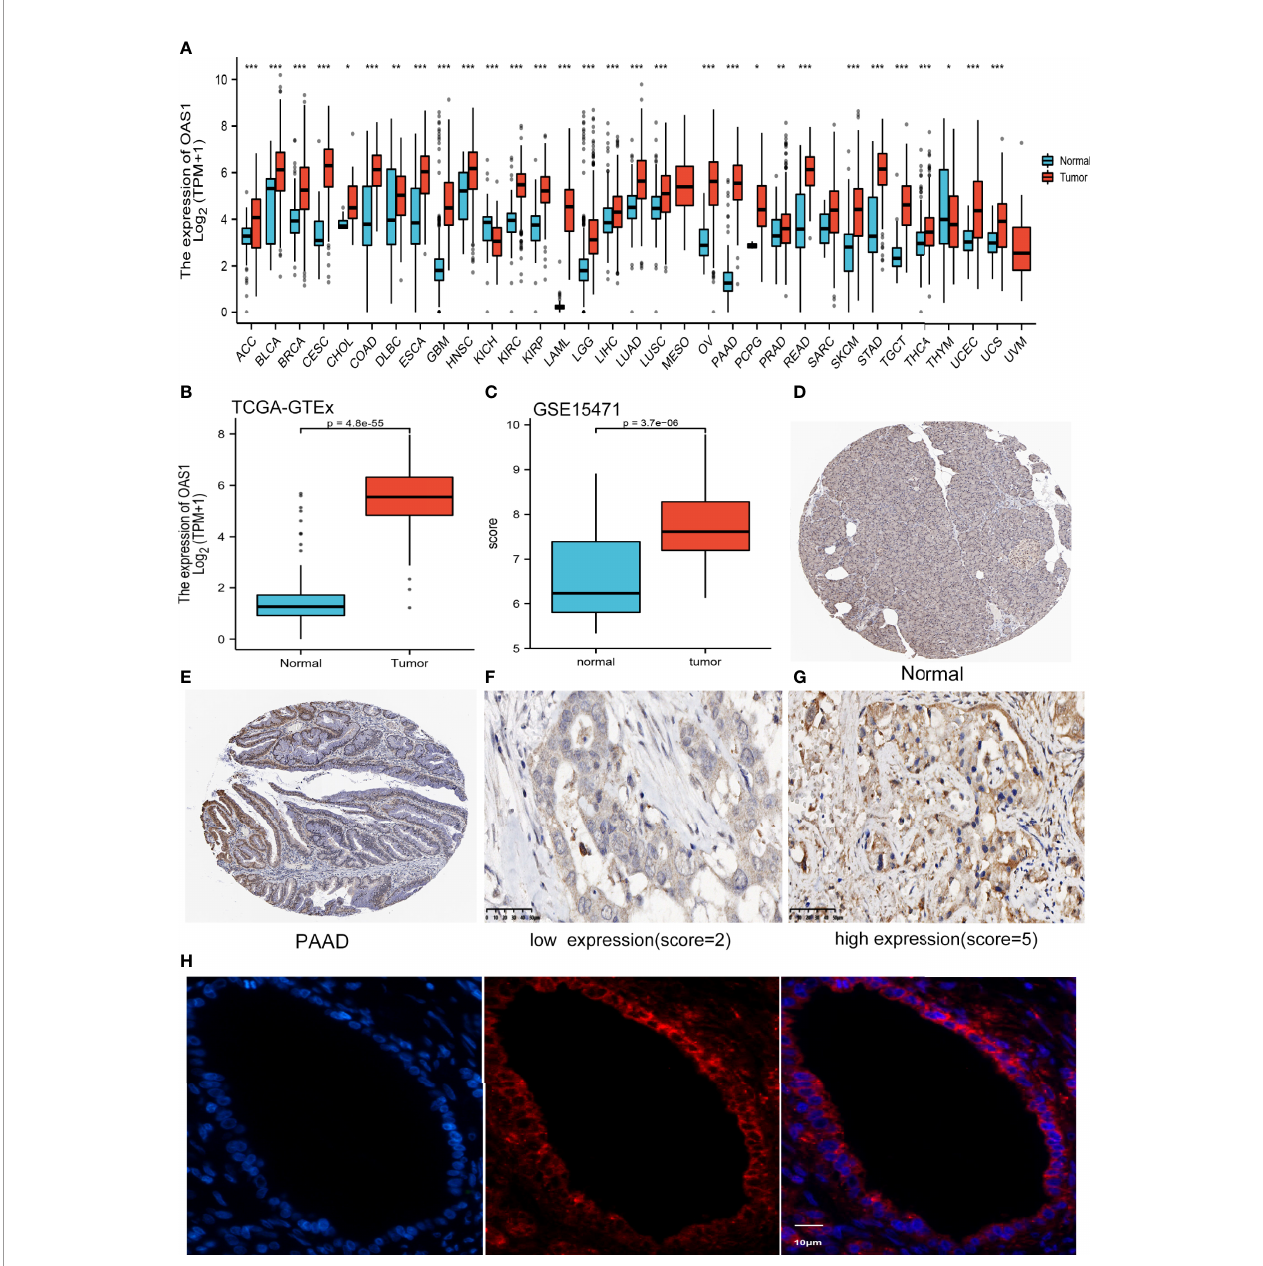
FIGURE 1 | The expression of OAS1 (A) OAS1 expression in different types of cancers (*P < 0.05, **P <0.01, ***P < 0.001). (B) OAS1 expression in pancreatic cancer and normal pancreatic tissue base on TCGA-PAAD. (C) OAS1 expression in pancreatic cancer and normal tissue base on GSE15471 of GEO. (D, E) The protein levels of OAS1 between normal pancreatic tissue and pancreatic cancer tissue based on HPA. (F, G) Representative Images of low (F) /High (G) protein expression of OAS1 in 45 patients with PAAD (original magni fi cation:X400). (H) Localization of OAS1 (red) was observed by immuno fl uorescence confocal microscopy. The nuclei were stained (blue) with DAPI. Representative pictures are